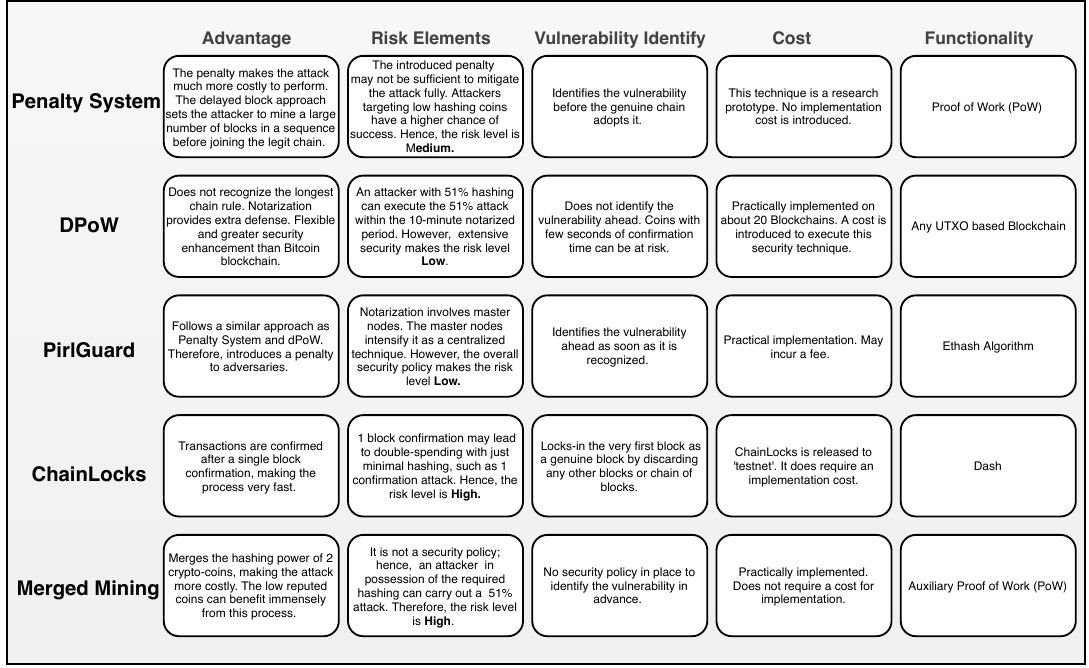
Figure 6. A security-based framework of defense mechanisms based on the 51%